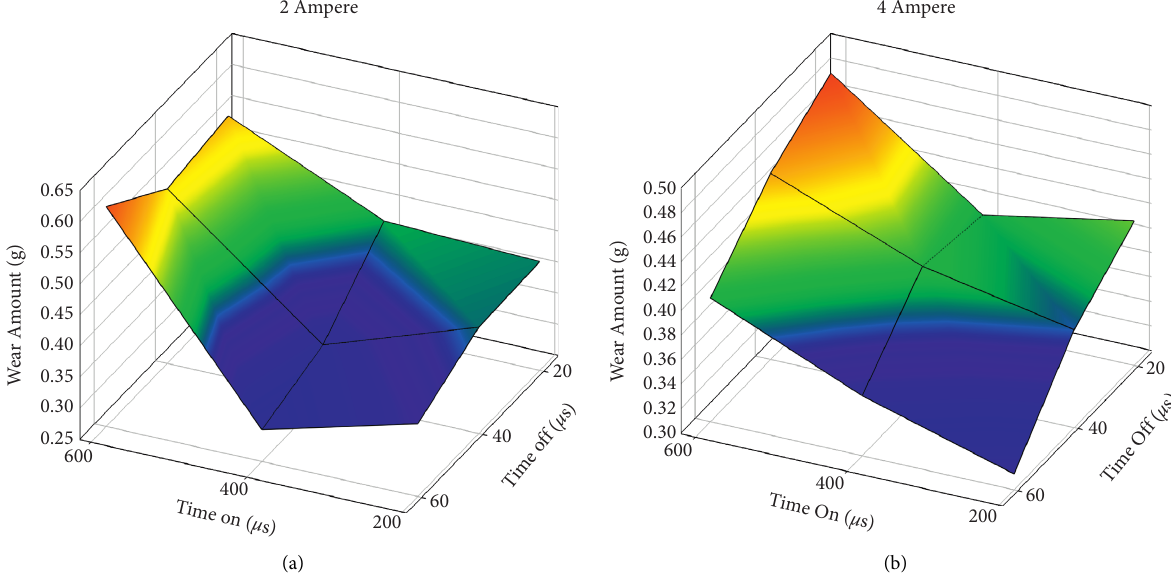
Figure 4: Effect of pulse time-on and time-off on wear amount at 2 (a) and 4 (b) amperes.